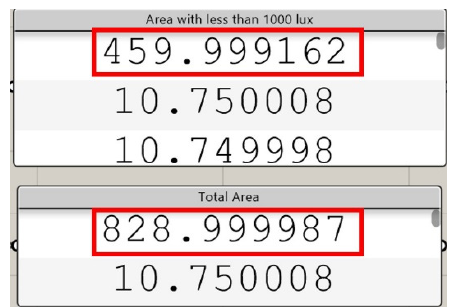
Figure 13. Calculation of Area with Less than 1000 Lux.